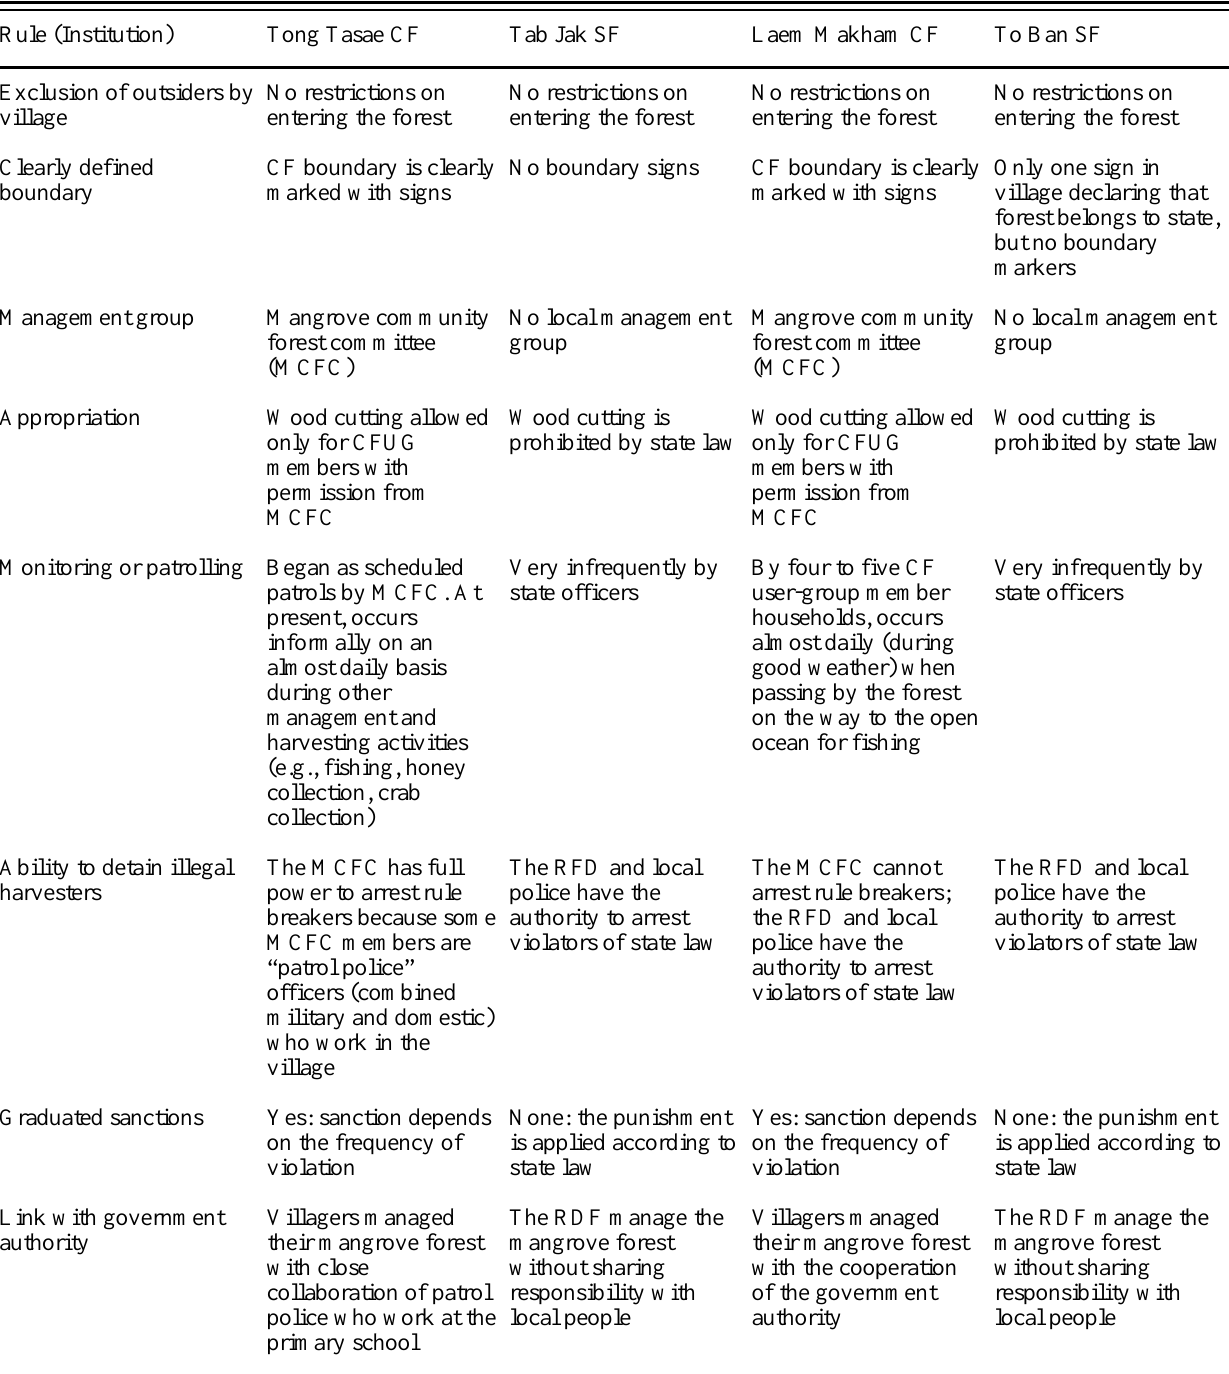
Table 2. Institutional arrangements over community and state forests at two sites in Trang, southern